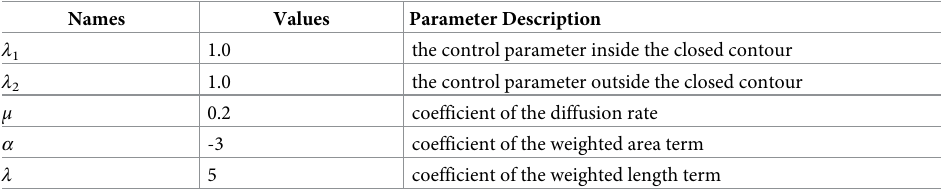
Table 1. Value information table of each